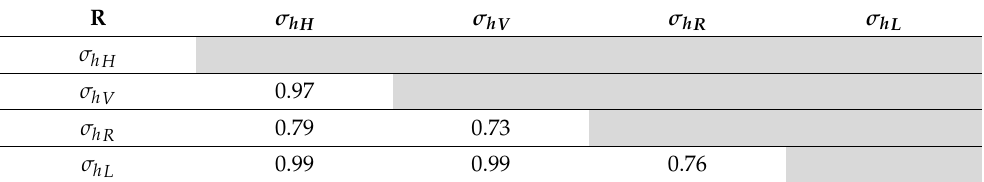
Table 3. Pearson Correlation (R) between PO modeled rms height ( σ h ) at different polarizations. R σ hH σ hV σ hR σ hL σ hH